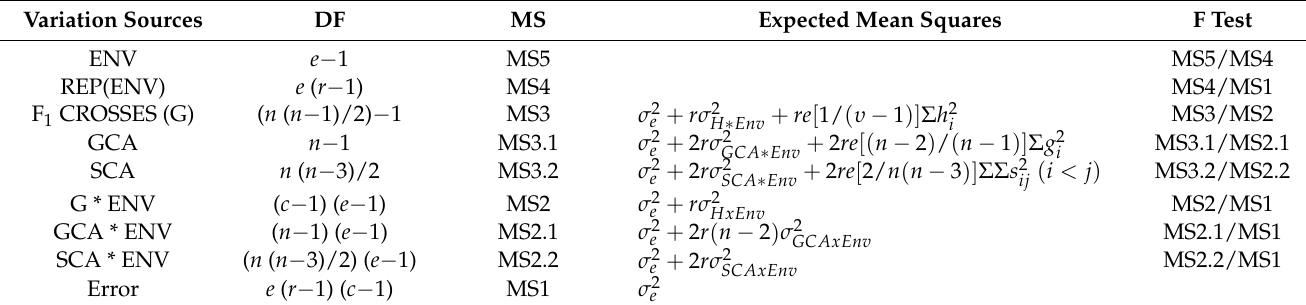
Table 5. Combined analysis of variance across environments for a Griffing modified design, and contrast analysis for GCA and SCA and their interactions with